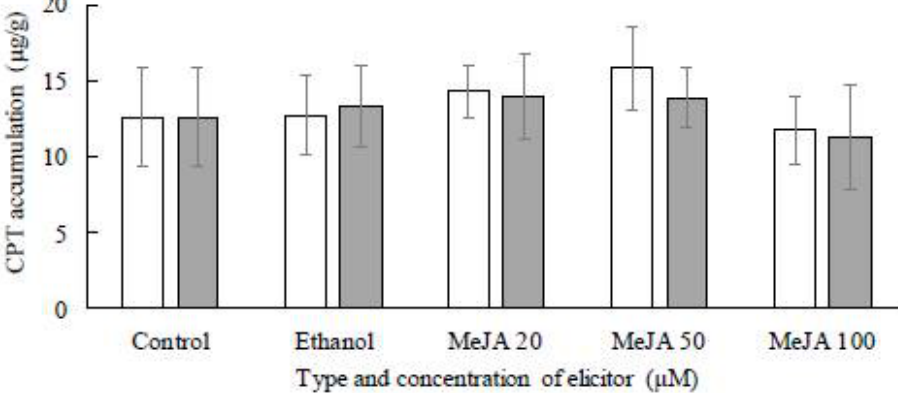
Figure 6. Effects of MeJA elicitation on CPT concentration in leaves by elicitation with ethanol and MeJA (20, 50 and 100 µM) for 12 h (□) and 24 h ( ■ ) before harvesting. The values are expressed as mean ± SD ( n = 3).